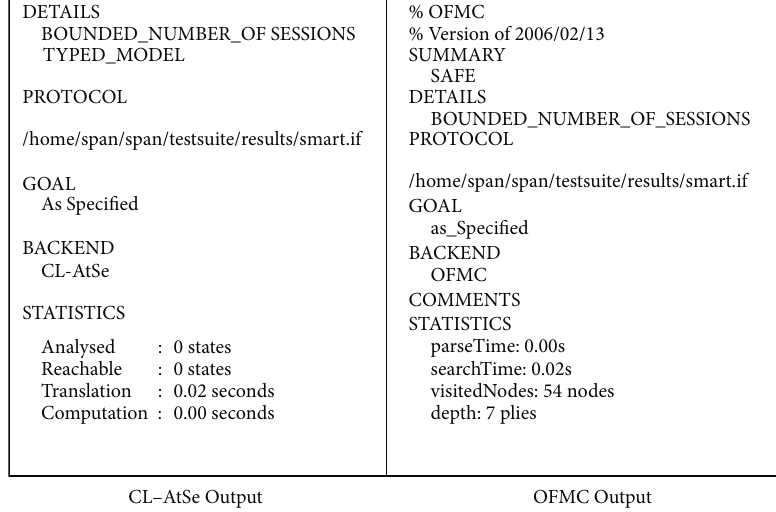
Figure 13: The results using OFMC and CL-AtSe backends. Table 2: The computational time of crypto-operations [51, 52].